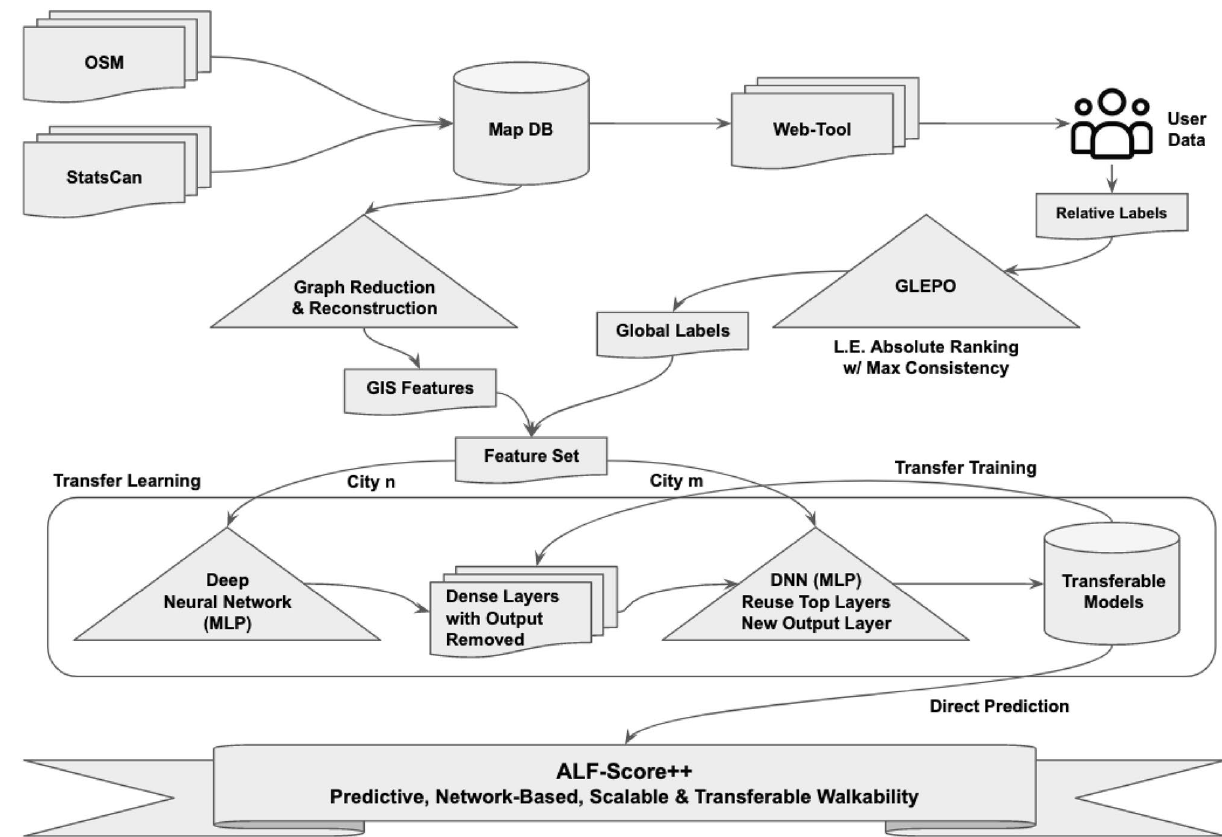
Figure 1. ALF-Score++ utilizes features similar to that of ALF-Score and ALF-Score+ such as road network structure, POI, centrality measures and road embedding. GLEPO’s linear extension of user opinions 18 that produces a global view of relative user opinions, is then aligned with the features as an input to the machine learning processes. Models trained by ALF-Score++ are applicable to cities previously seen and unseen by the algorithms during the training processes. Walkability estimates that are produced through trained models will have a high spatial resolution, be representative of user opinion and provide a better insight of different regions and neighbourhoods. (Figure drawn by the